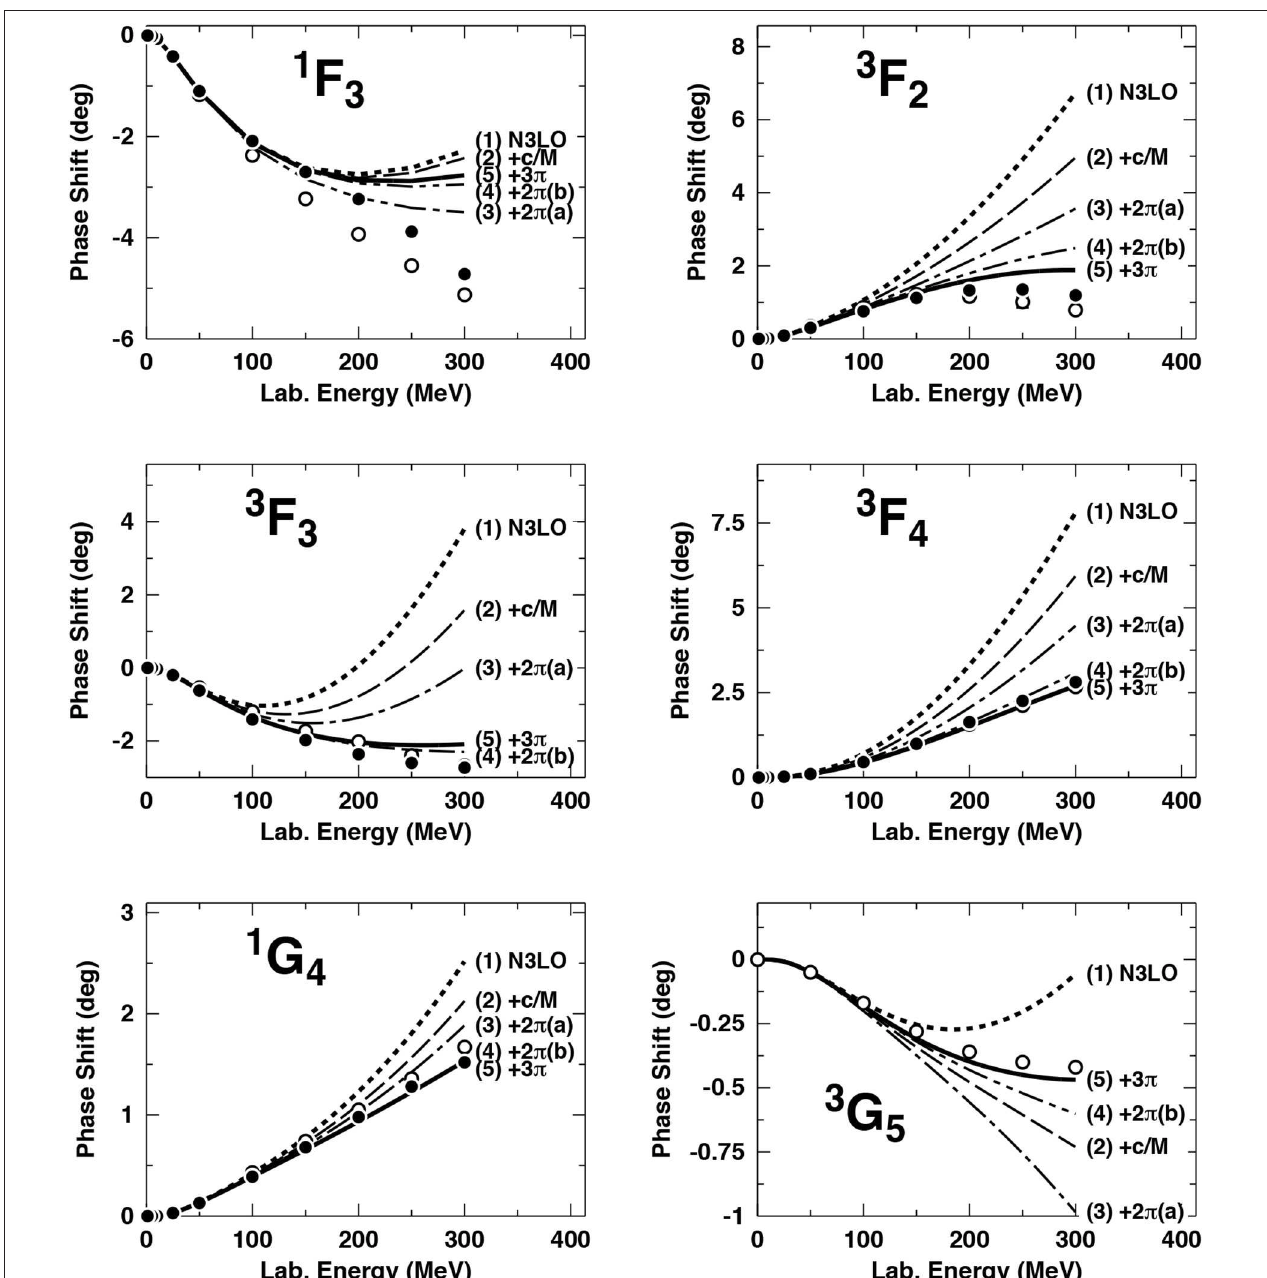
FIGURE 9 | Effect of individual fifth-order contributions to the neutron-proton phase shifts of some selected peripheral partial waves. The individual contributions are added up successively in the order given in parentheses next to each curve. In all cases an SFR cut-off ˜ 3 complete N 4 LO. The filled and open circles represent the results from the Nijmegen multi-energy np phase-shift analysis [93] and the VPI-GWU single-energy np analysis SM99 [91], respectively. Reprinted figure with permission from Entem et al. [46], copyright (2015) by the American Physical Society.